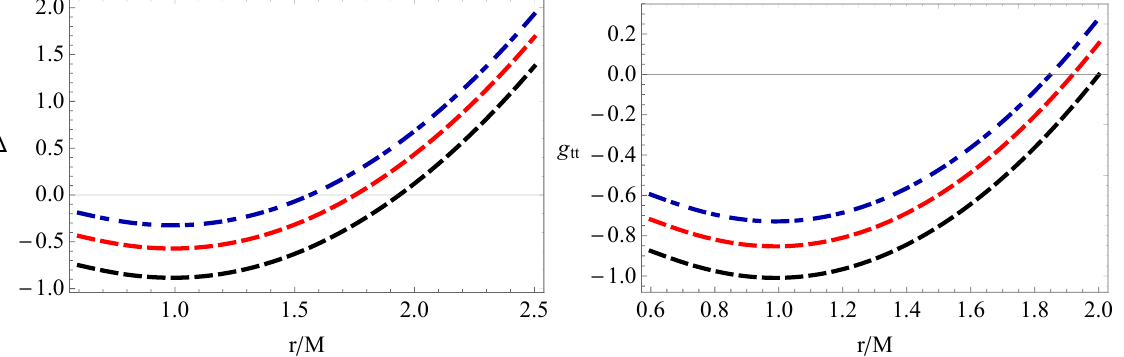
Figure 1. The plot of ∆ and g tt as a function of raial coordinate for different values of angular momentum, black curve ( a = 0.5), red curve ( a = 0.75) and blue curve ( a = 0.9), respectively. We have set b / M = 0.5 in both plots and θ = π /4 in the second